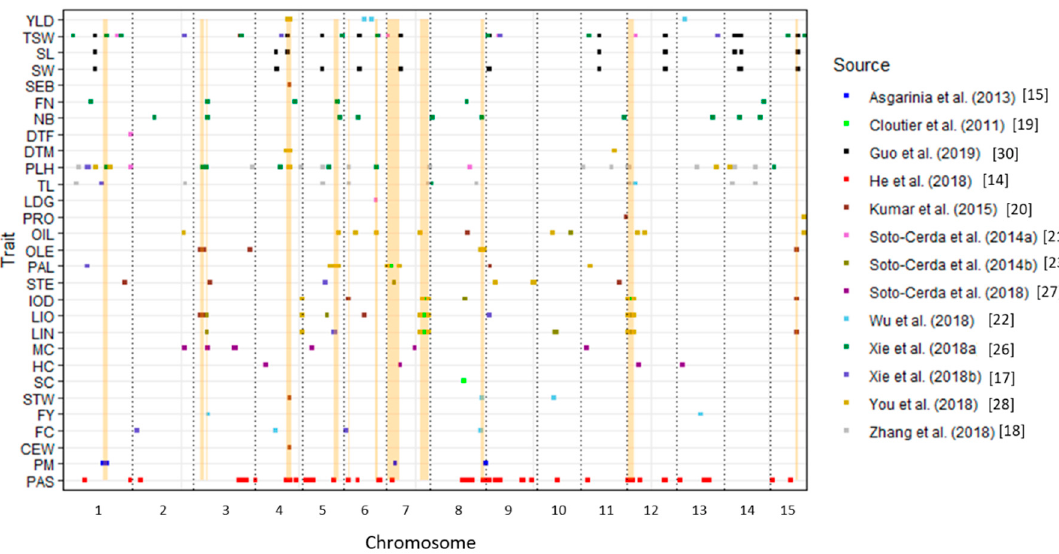
Figure 1. Distribution of 308 QTL associated with 29 traits mapped onto flax chromosomes. Of these QTL, 67 for pasmo resistance and 46 for thousand-seed weight, seed width and seed length have been previously mapped on the most recent release of the flax chromosome-scale pseudomolecules [14,30]. Two fusarium wilt QTL [24] were not included because of incomplete information. Co-located regions are highlighted in yellow. See Table 1 for the trait name abbreviations.